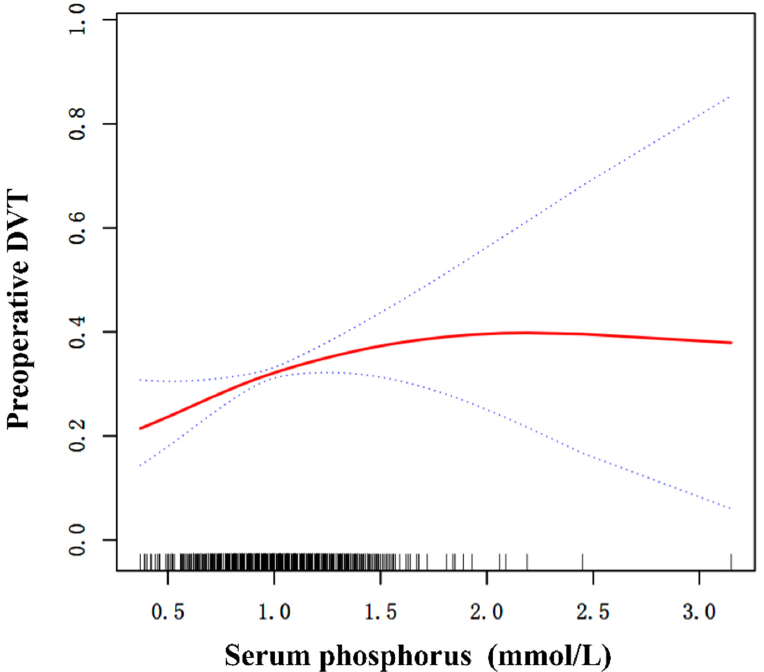
Figure 1. Curve fitting between preoperative serum phosphorus and DVT. Adjusted for sex, fracture classification, multiple injuries, dementia, time to operation. Table 4. Nonlinearity of preoperative serum phosphorus and DVT.